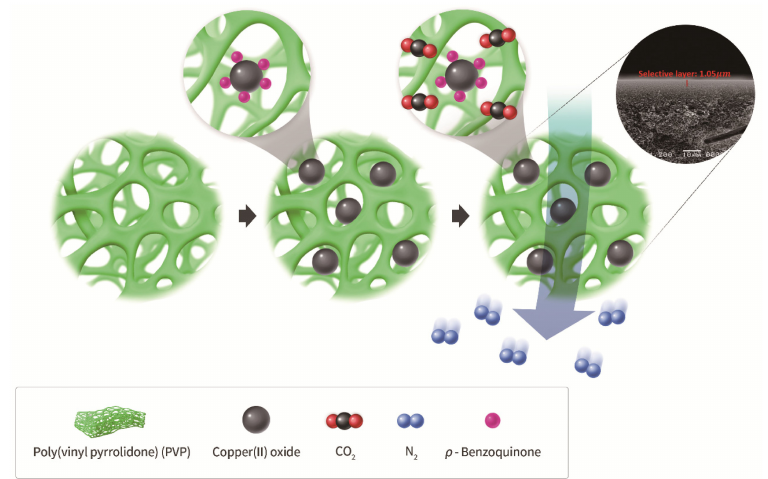
Figure 8. N 2 separation by PVP/CuO/ p -BQ composite